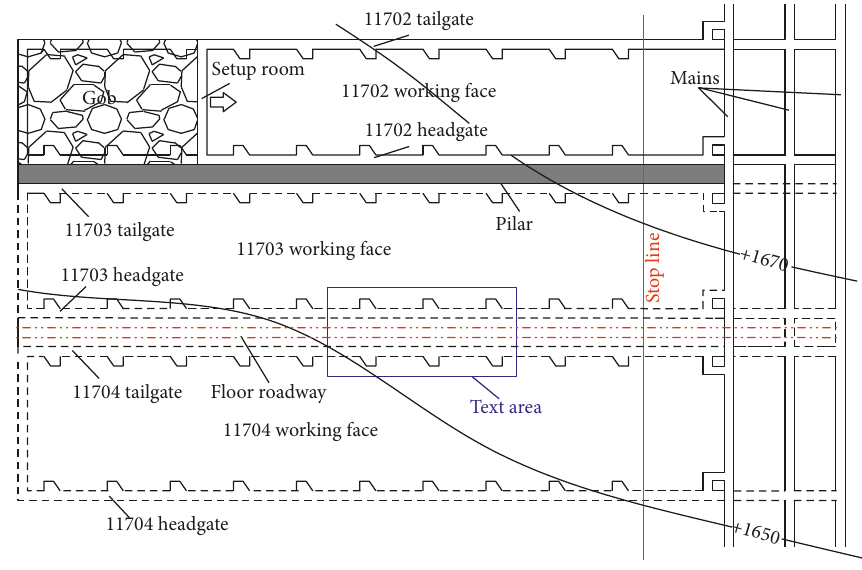
Figure 5: Location of test area. Table 1: Mechanical properties of each geological unit.